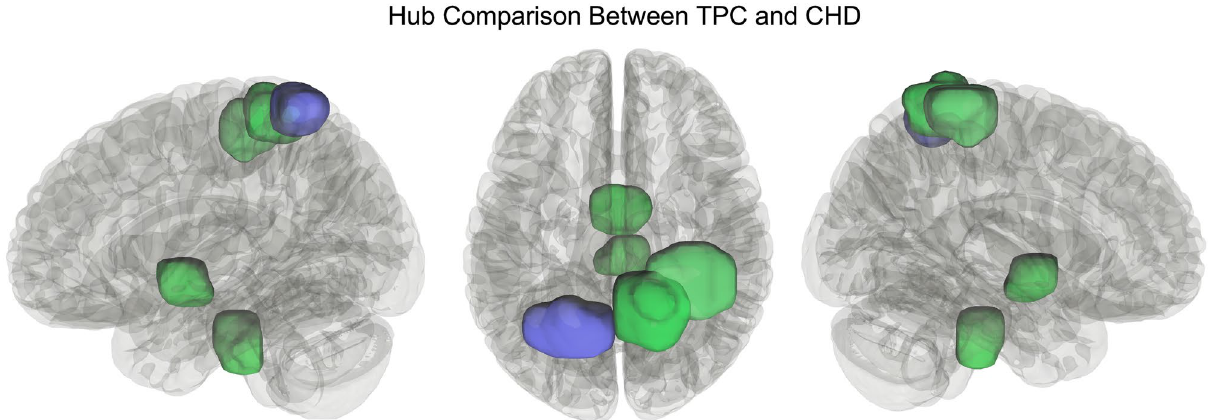
Figure 3. Results of hub analyses between the two groups. Green hubs are those shared by both groups (brain stem, midbrain, and two regions of the right superior parietal lobule). Purple hubs are those only resolved in TPC (1 additional region in the left superior parietal